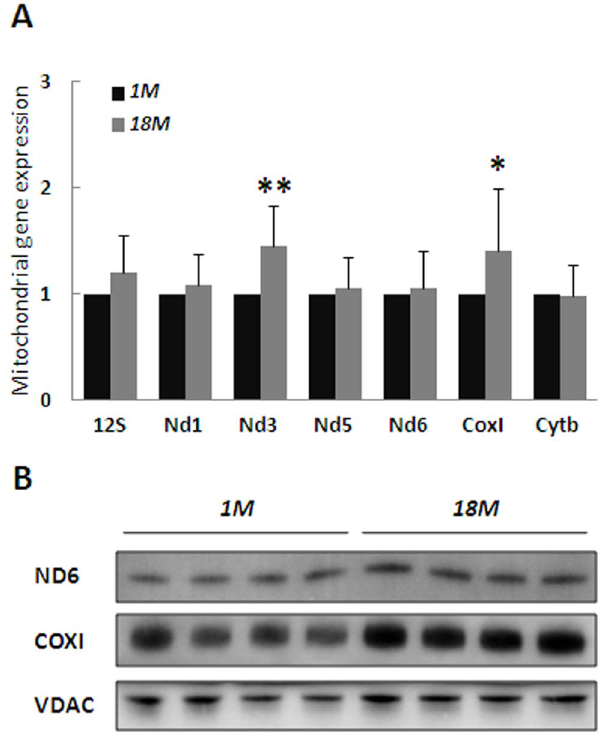
Figure 5. Stable Expression of Genes and Proteins with Age. (A) Expression of mitochondrial genes was analyzed by RT-qPCR normal- ized to Gapdh and presented relative to 1 month old mice. (B) Expression levels of proteins were evaluated by western analyses using antibodies as specified in Experimental Procedures. The relative increase in COXI and ND6 with age is indicated. Figure shows mean with SD. **p , 0.01, *p , 0.05.